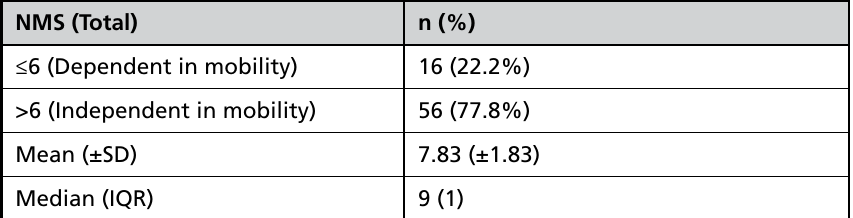
table 2: Frequency of nMs total scores (n=72)